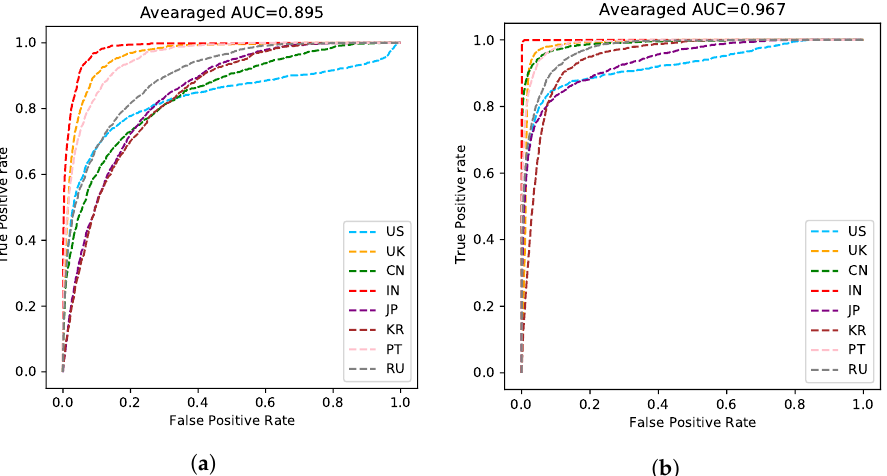
Figure 5. ROC curve of each accent. ( a ) The baseline version without the auxiliary ASR task. The averaged Area Under Curve (AUC) score is 0.895. ( b ) The proposed MTL version. The averaged Area Under Curve (AUC) score is